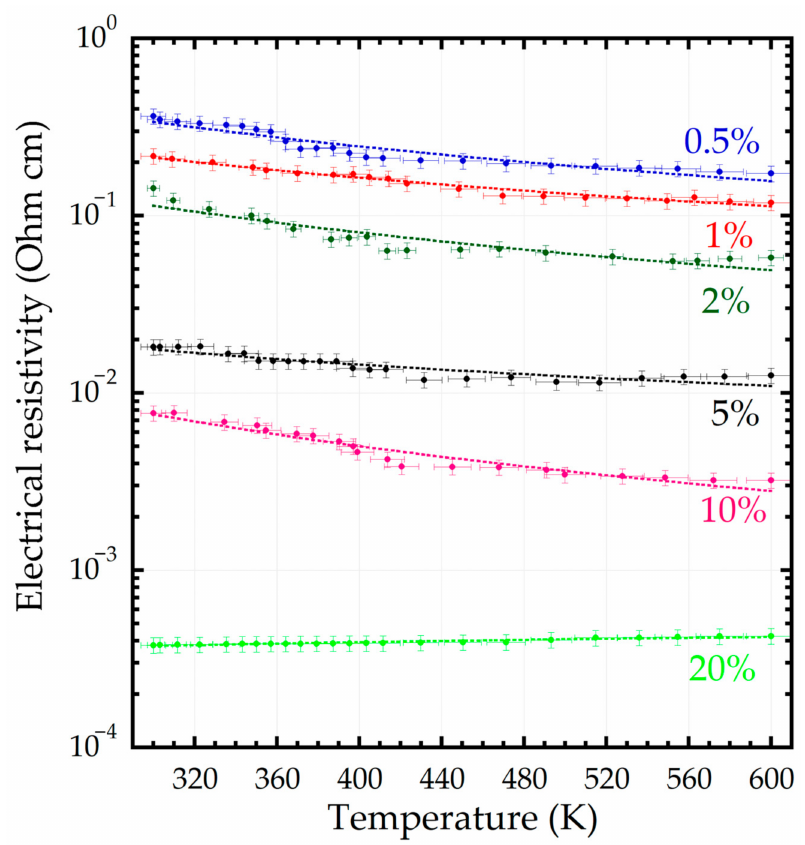
Figure 6. Electrical resistivity values as a function of the